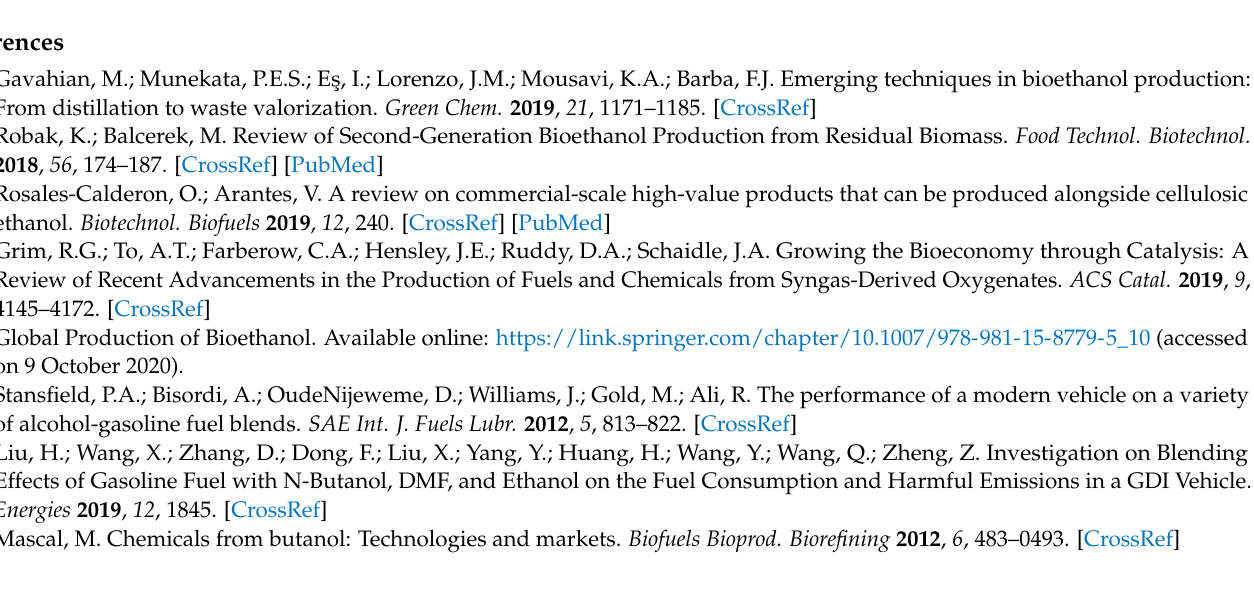
view, Table S1: Summary of purchase cost for main equipment units, Table S2: Assumptions for economic model, Table S3: Economic parameters for different plant